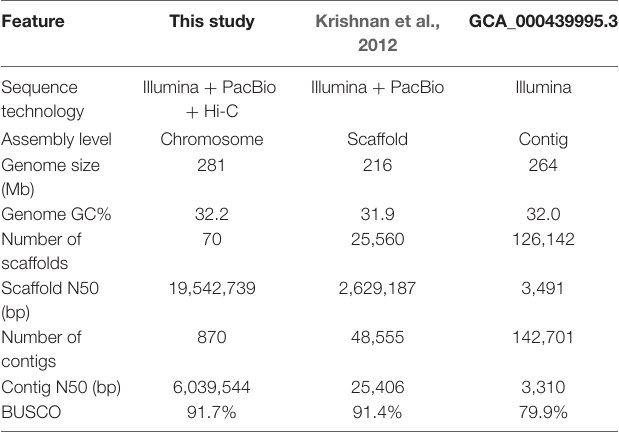
TABLE 2 | Comparison of the A. indica genome assembly